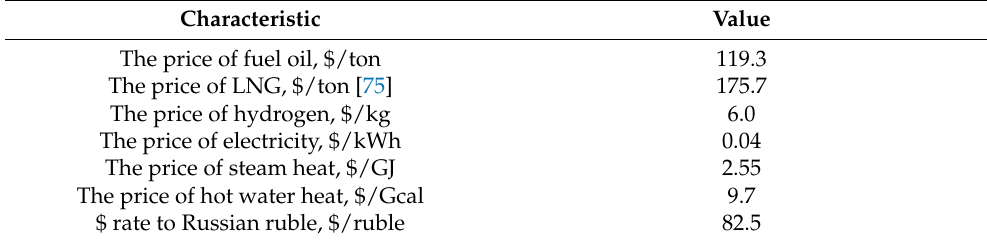
Table 9. Initial data for calculating the storage system of liquefied hydrogen and LNG as a backup fuel.